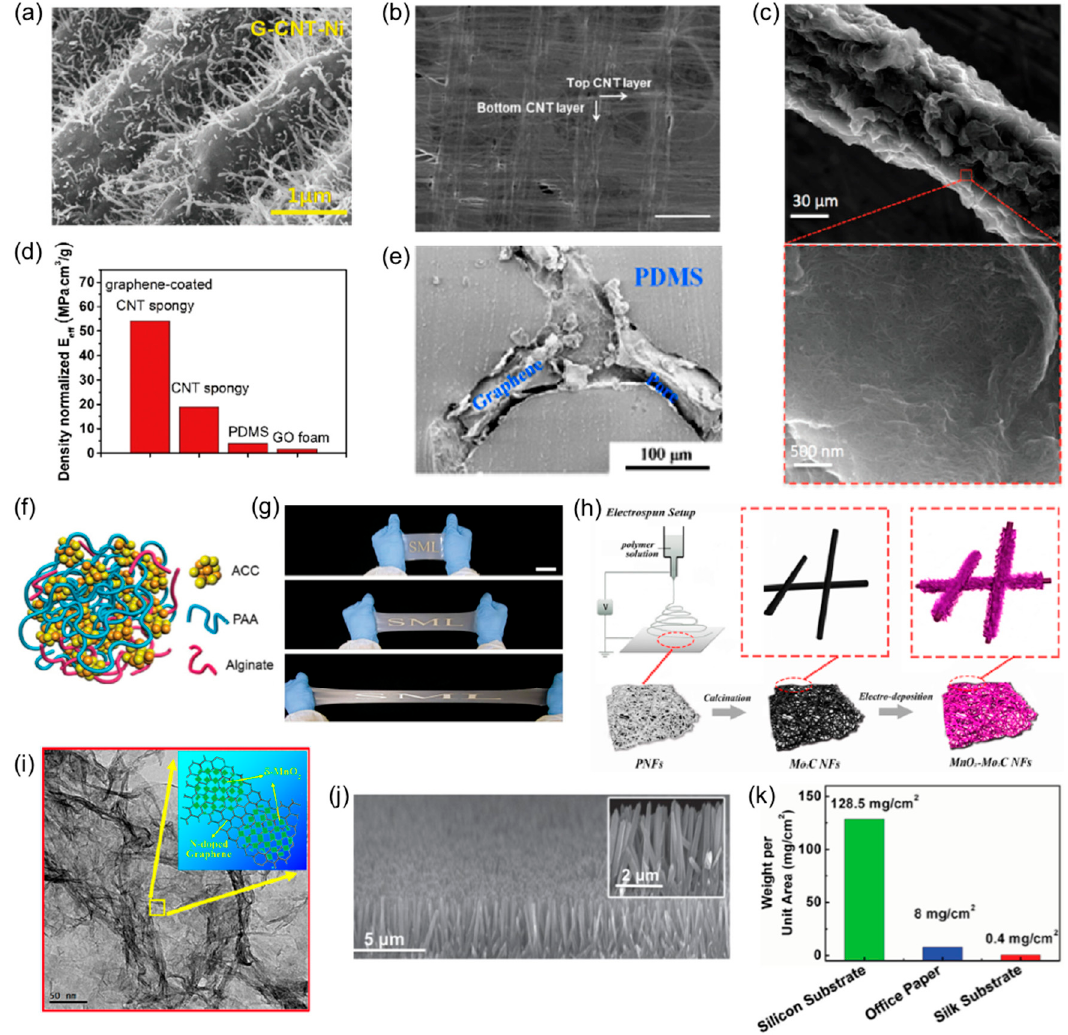
Figure 1. Soft functional materials. ( a ) Graphene-CNT-nickel hetero-nanostructure. Reprinted